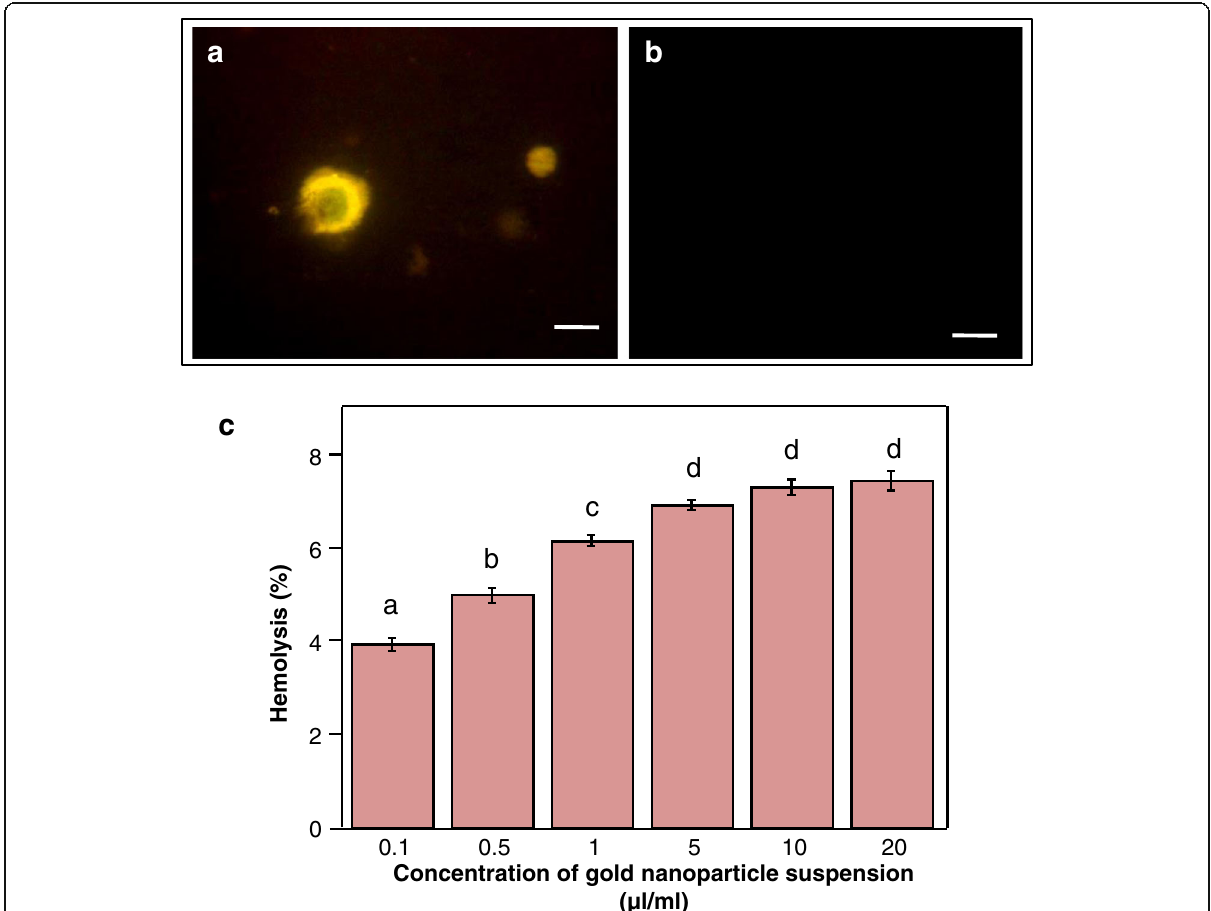
Fig. 10 Gene delivery using AuNPs into Sarcoma 180 cancer cells and hemolysis assay with human erythrocytes; fluorescence microscopic image of a cancer cells expressing green fluorescence protein after uptake of DNA-AuNP complex and b control cells treated with free plasmid DNA (bars = 20 μ m). c Percentage hemolysis with different dilutions of AuNPs. Data represents means ± SE of three replicates. Different letters